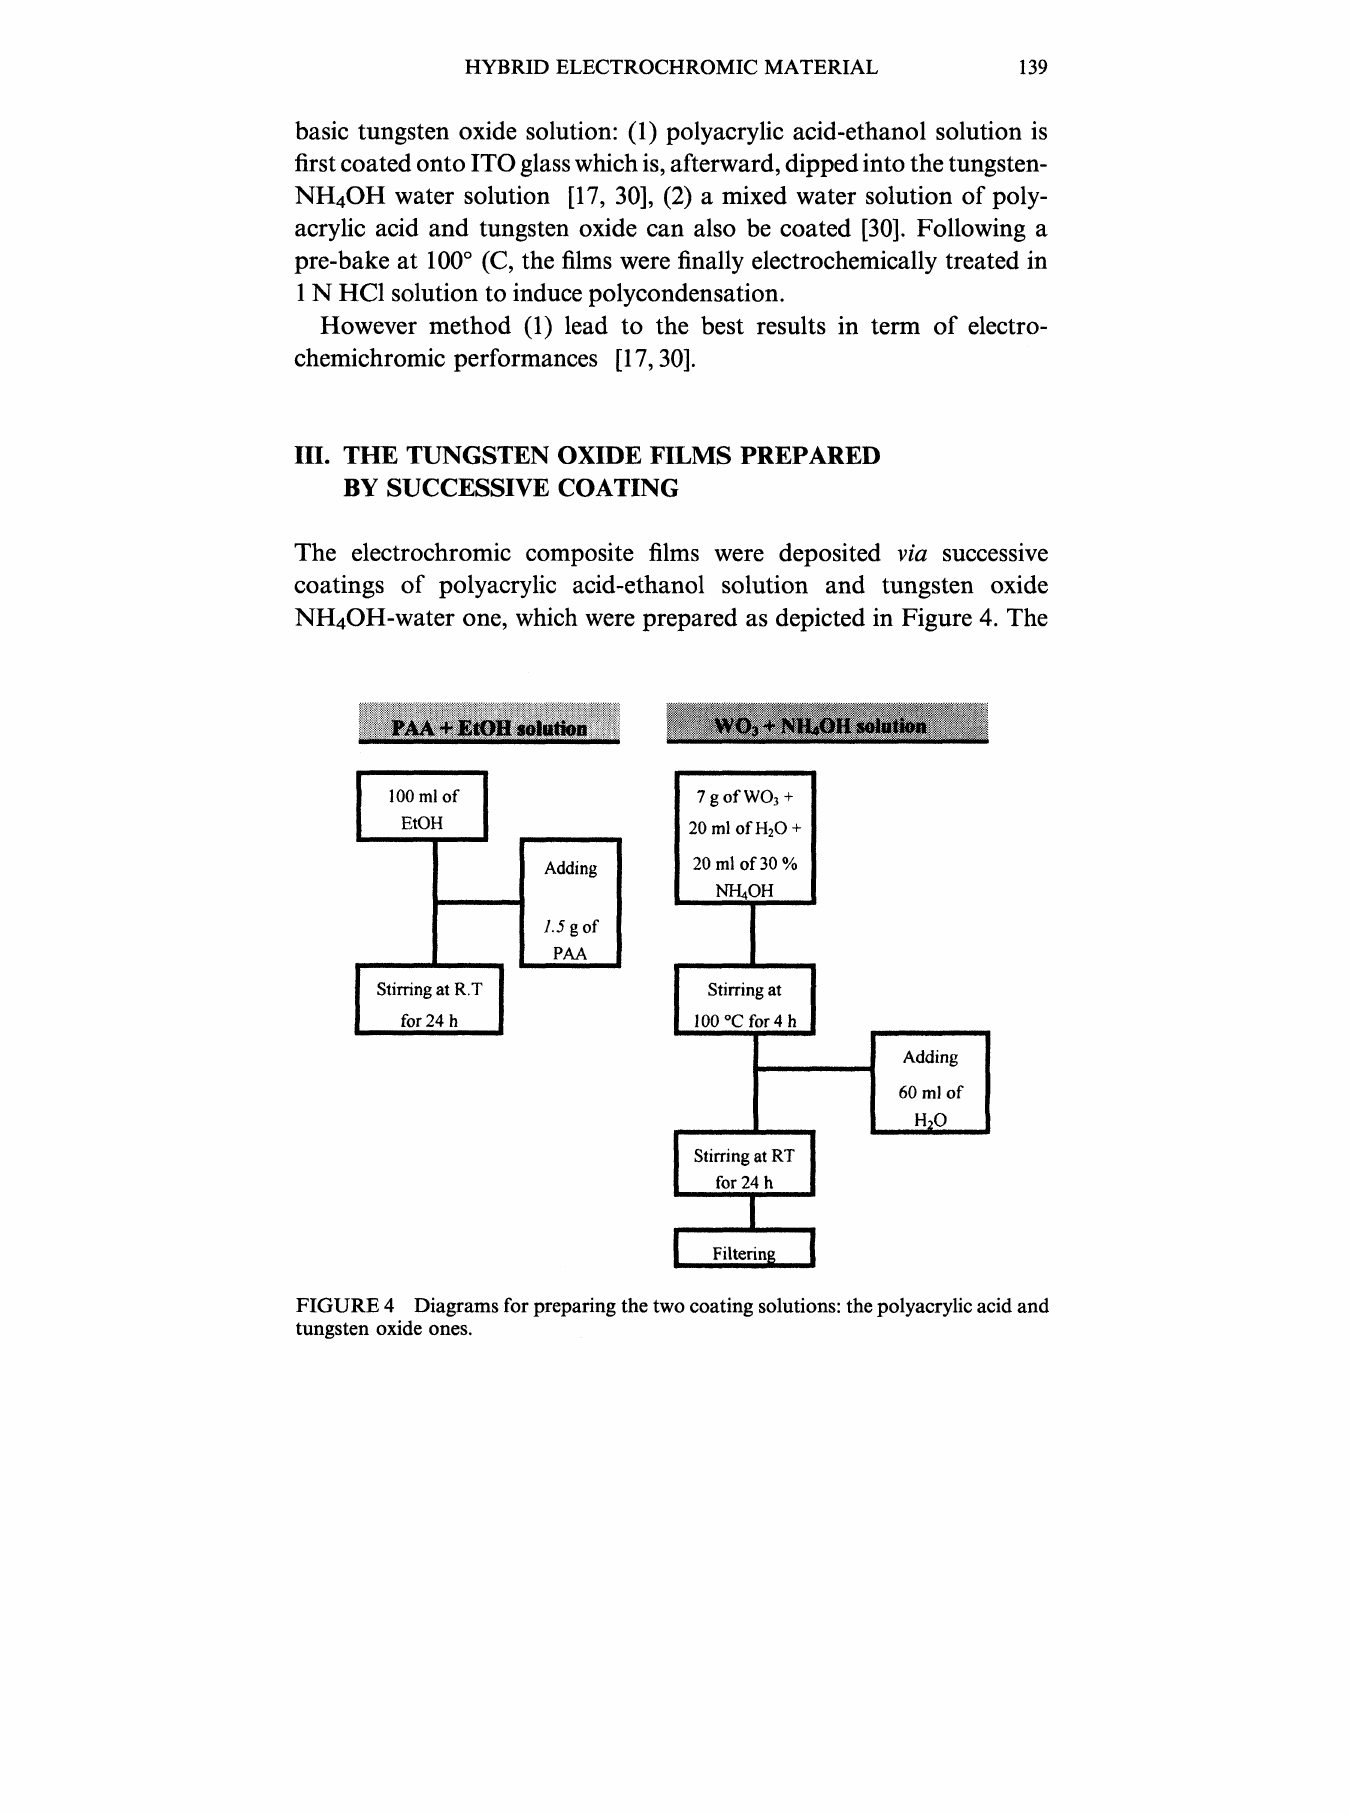
FIGURE 4 Diagrams for preparing the two coating solutions: the polyacrylic acid and tungsten oxide